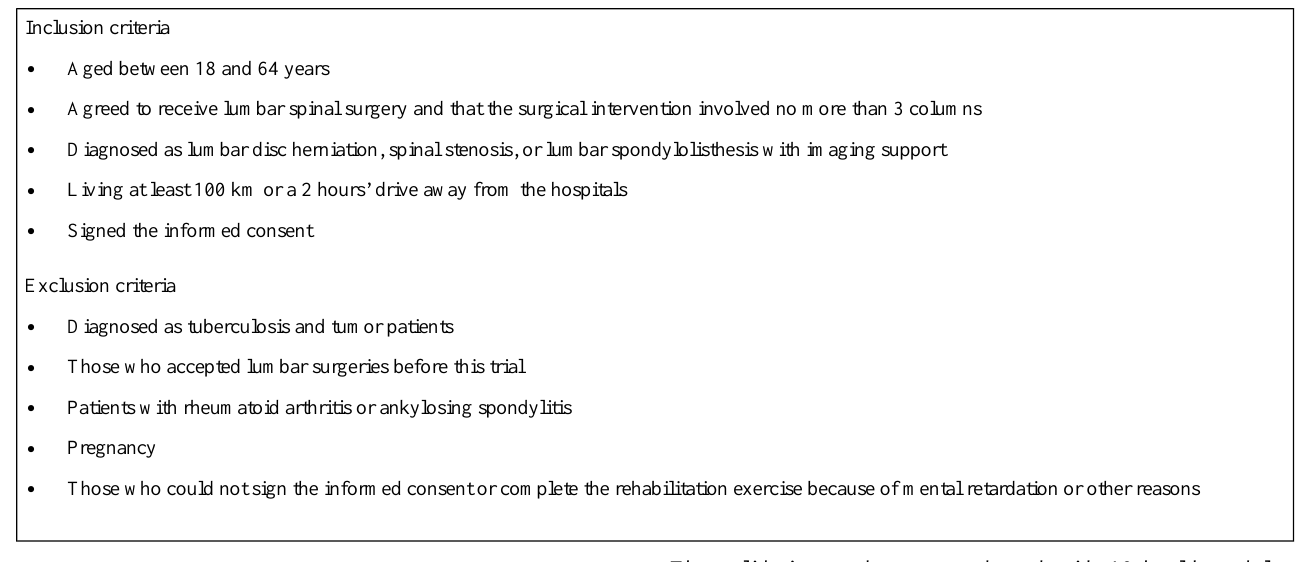
Textbox 1. Inclusion and exclusion criteria for the